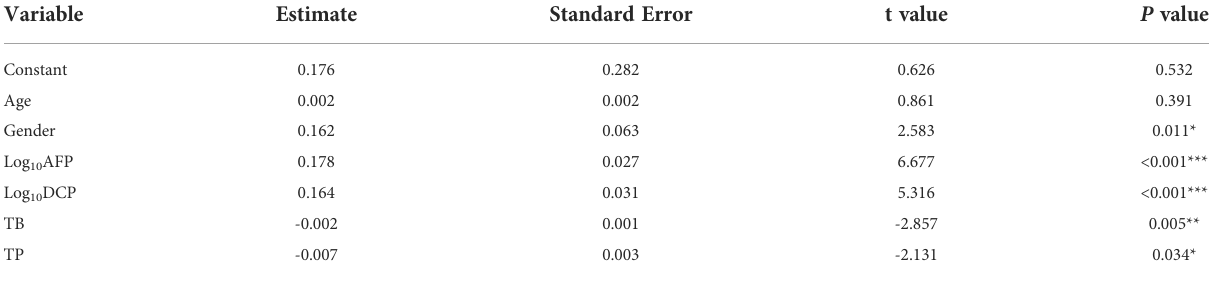
TABLE 2 Parameter estimation of variables by logistic regression in GAADPB model.